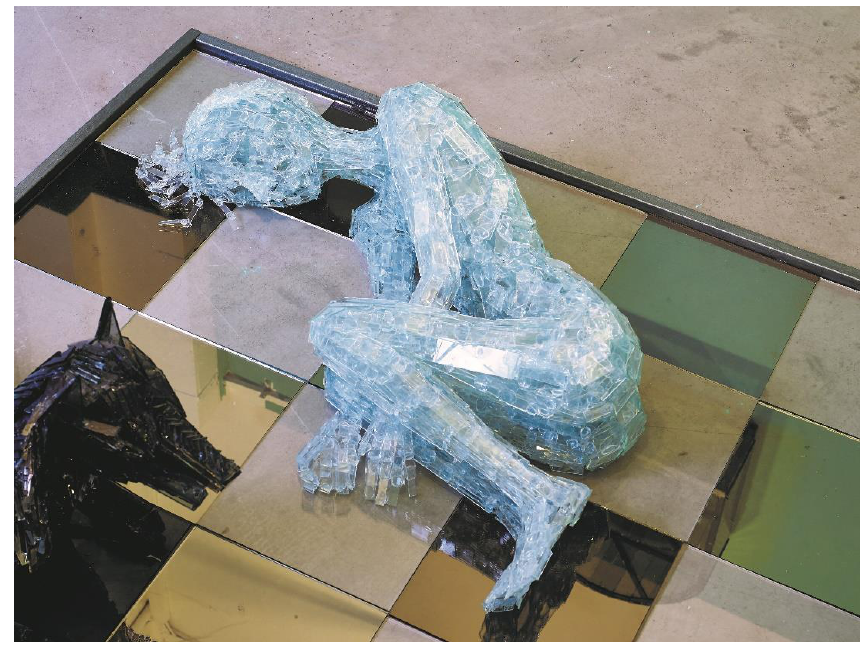
Figure 4. Alina Rom Cohen, 1700 km, 2019